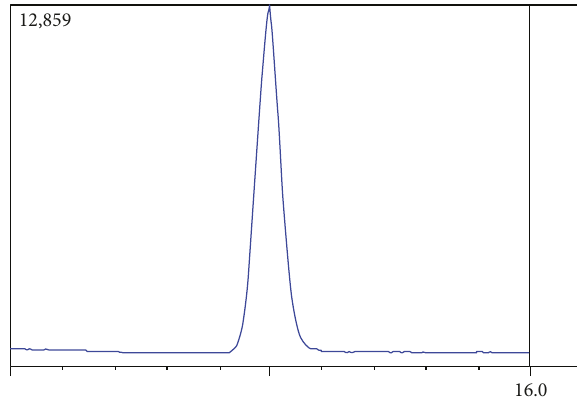
Figure 14: Chromatogram after adsorption of 200ppm dieldrin standard using ZnO